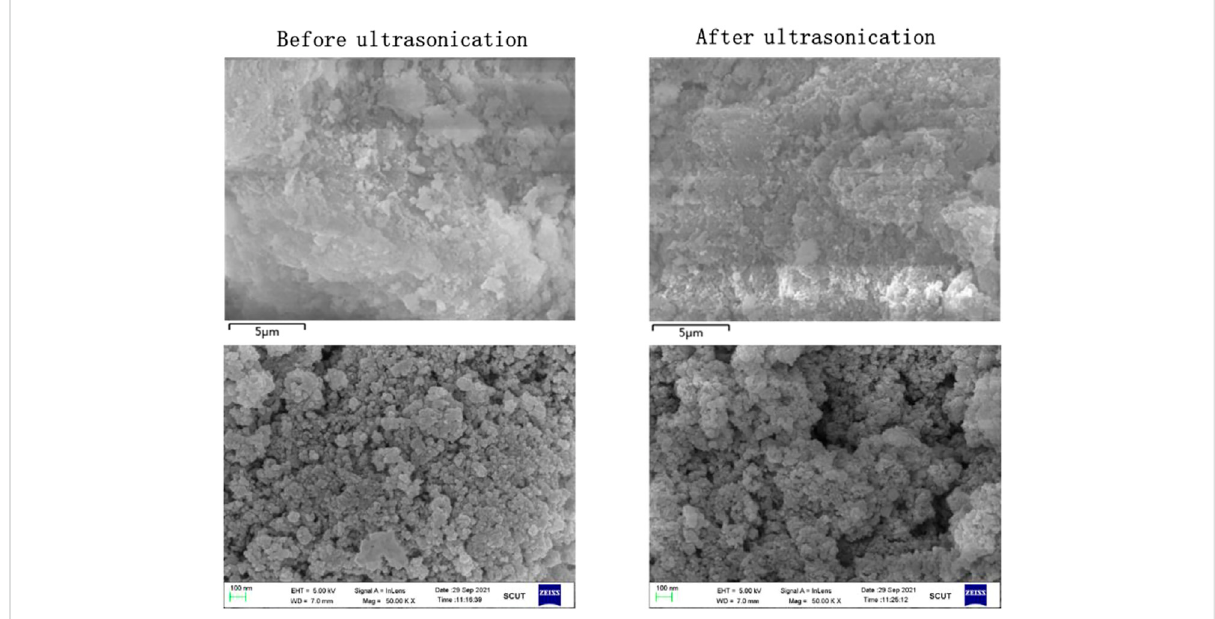
FIGURE 11 Topography change of complex sludge (EPS2) before and after ultrasonic treatment.